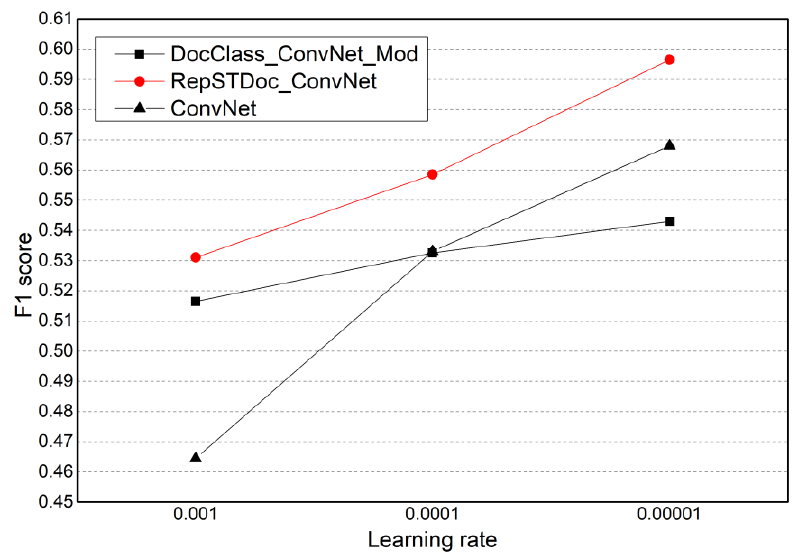
Figure 4. The effect of learning